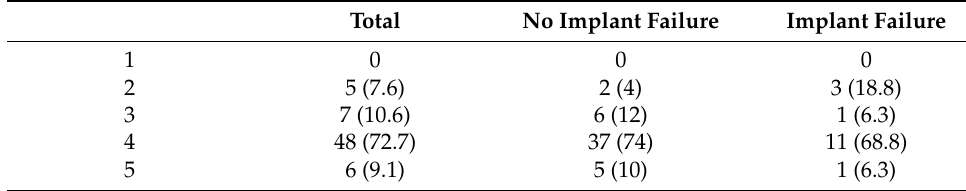
Table 2. Osteoporotic fracture classification